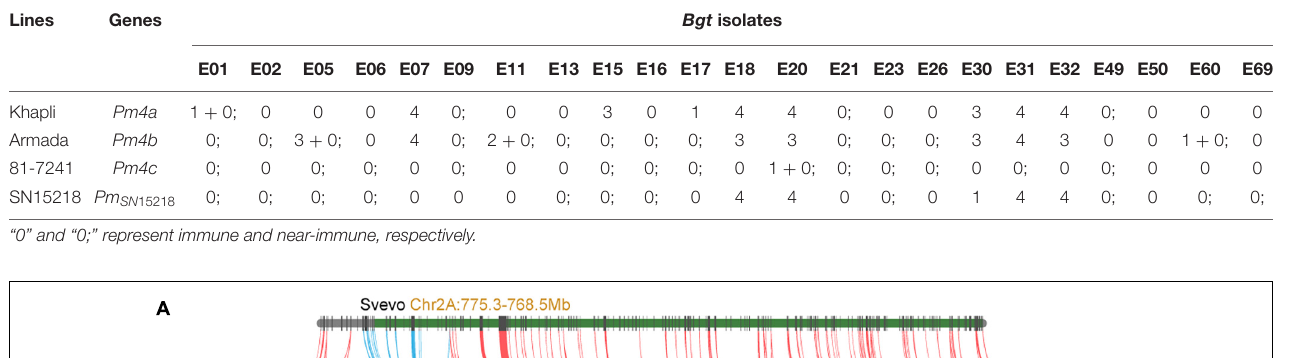
TABLE 3 | Resistance spectra of Pm SN 15218 and different Pm4 genes. Lines Genes Bgt isolates